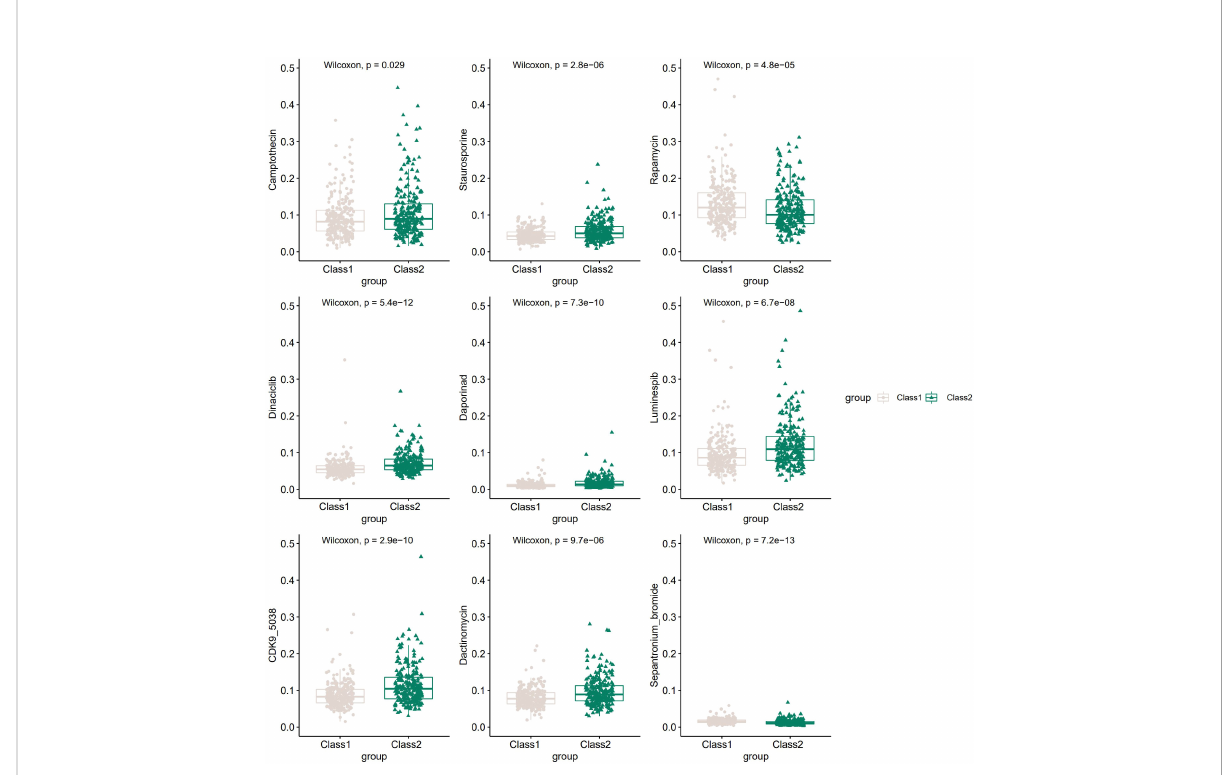
FIGURE 6 The potential drugs and diverse drug sensitivity between the two Classes of PCa patients.The vertical coordinate represents